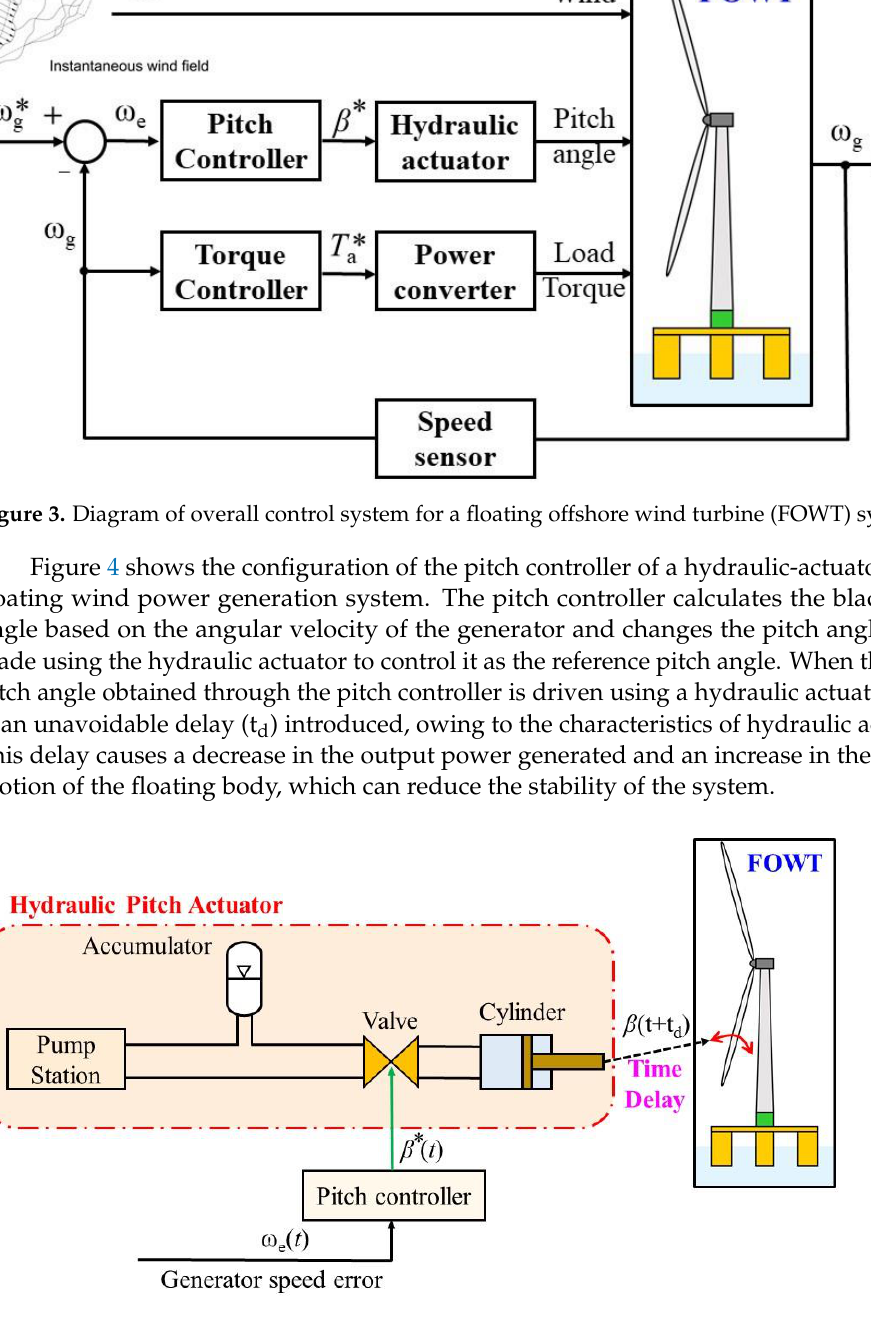
Figure 3. Diagram of overall control system for a floating offshore wind turbine (FOWT) system.